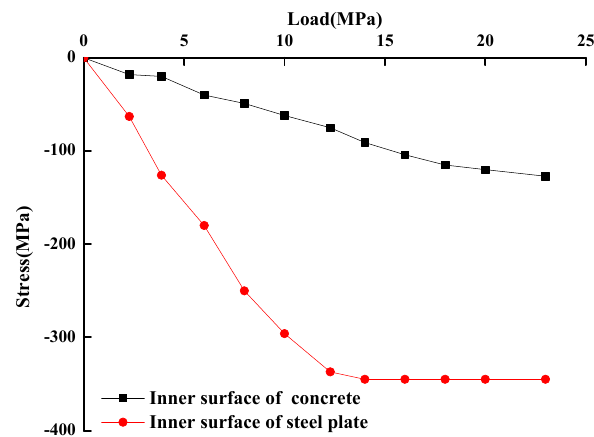
Figure 11. Load–hoop stress curve of specimen ZJ6. Figure 12. Load–hoop stress curve of specimen ZJ8. Figure 9. Load–hoop stress curve of specimen ZJ1. Figure 10. Load–hoop stress curve of specimen ZJ4.